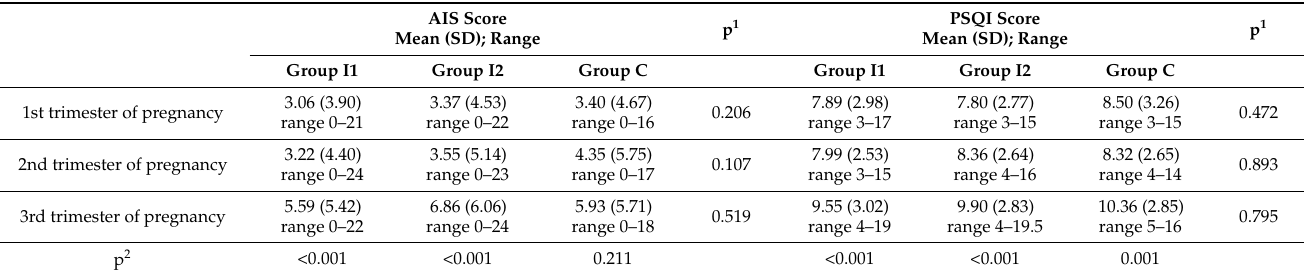
Table 3. Mean score of insomnia and poor quality of sleep throughout pregnancy. AIS Score Mean (SD);